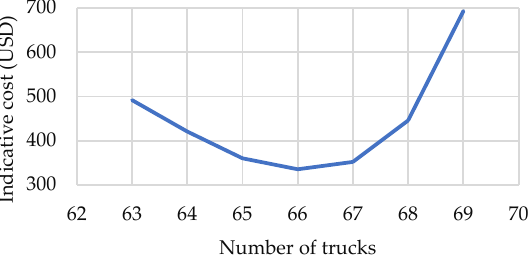
Figure 8. Indicative cost as a function of number of trucks to all warehouses for Scenario 1.